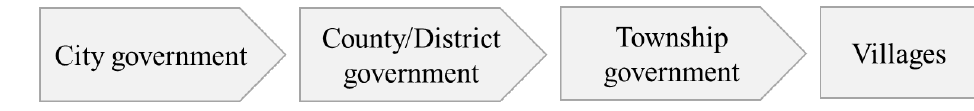
Figure 1. The administrative structure about township in China.